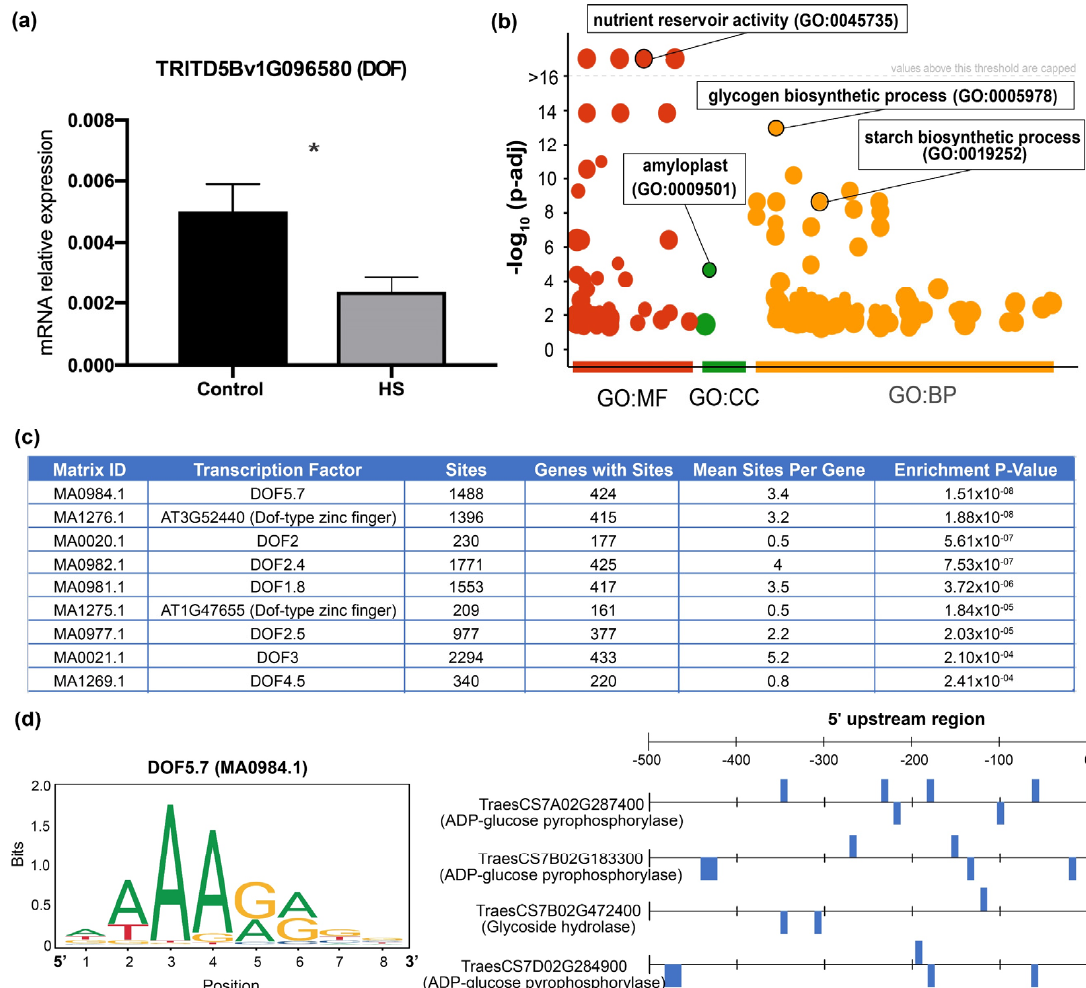
Figure 7. The predicted targets of a highly connected DOF TF gene ( TRITD5Bv1G096580 ) are involved in glycogen and starch biosynthesis. ( a ) qPCR analysis of the TRITD5Bv1G096580 gene in response to 3 h of HS in durum wheat grains. Relative expression with ± standard deviations. Significant effects at Student’s t -test, p -value < 0.05 (*). ( b ) GO enrichment analysis of 438 target genes of TRITD5Bv1G096580 DOF TF. Each circle in the Manhattan plot represents a significant GO term (adjusted p- value < 0.05) using gprofiler2 software [51], and colors indicate the GO domain (MF: molecular function, CC: cellular component, BP: biological process). ( c ) The 10 most enriched DOF motifs in the promoter region of 438 target genes of TRITD5Bv1G096580 . The over-representation analysis was performed using the CiiiDER tool [54] and JASPAR 2020 database [53]. ( d ) Left panel: Base frequency analysis for the DOF5.7 (MA0984.1) motif obtained from the JASPAR 2020 database binding site [53], which is in the promoter sequences of putative target genes. Right panel: Schematic representation for the number and distribution of the DOF5.7 (MA0984.1) motif binding site (blue square) in gene promoter sequences of key enzymes of starch biosynthesis.